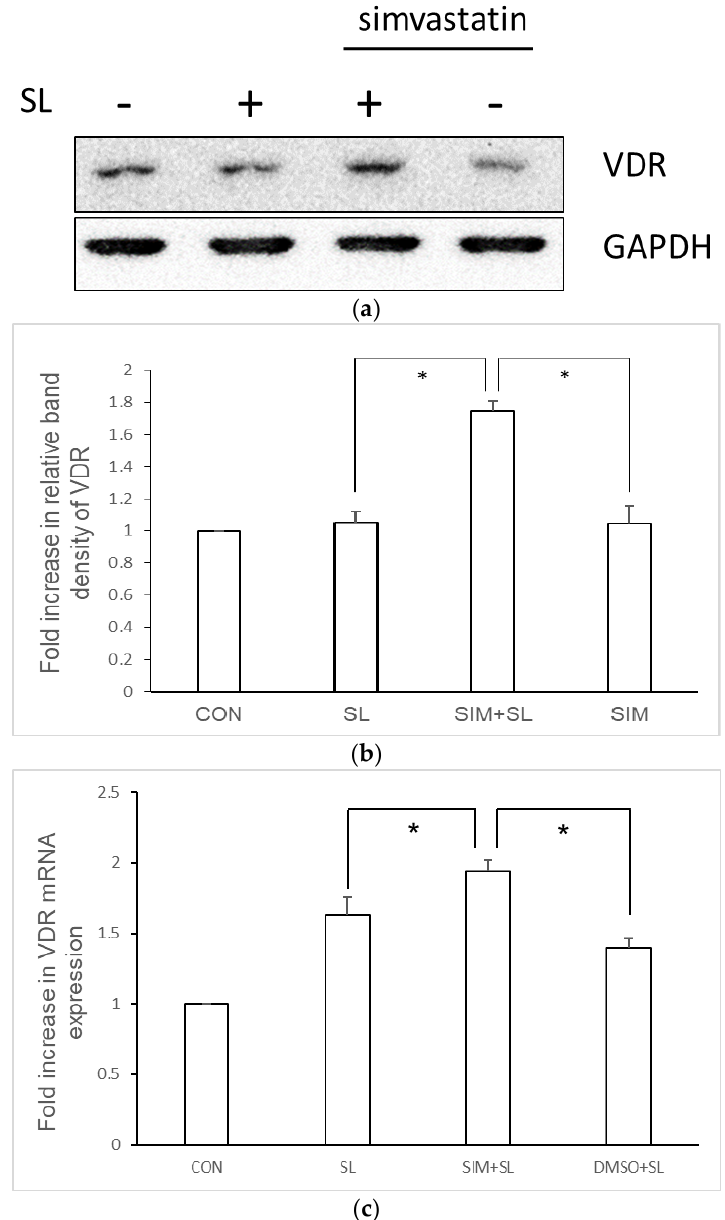
Figure 3. Simvastatin enhances vitamin D receptor (VDR) mRNA and protein expression in Salmonella -infected SW480 cells. After treatment with 10 μM simvastatin, SW480 cells were uninfected (CON) or infected with wild-type S. Typhimurium strain SL1344 (SL). VDR protein was detected in whole cell lysates by western blotting, which was normalized to GAPDH. Representative immunoblots ( a ) and densitometric quantification of immunoreactive bands ( b ) are shown. The relative band intensities of VDR ( b ) in SW480 cells were quantified as fold increases compared with the control cells. Each value represents the mean ± SD of three independent experiments (* p < 0.05). ( c ) Total RNA was extracted after infection and analyzed by real-time quantitative PCR to evaluate the VDR mRNA expression. VDR mRNA expression was normalized to the corresponding GAPDH mRNA expression and is shown as a fold increase over control cells. The results indicate the means and standard deviations for duplicate wells from at least three separate experiments (* p < 0.05).